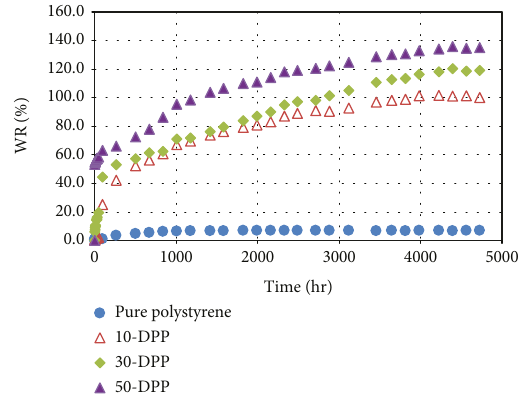
Figure 13: E ff ect of immersion time on water retention of DPP-polystyrene composites at room